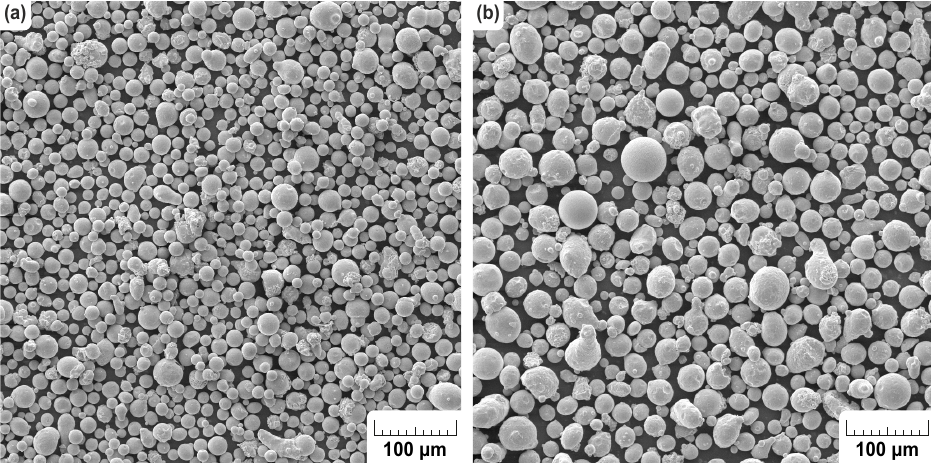
Figure 4. SEM pictures of H13 tool steel powder: ( a ) New, ( b )